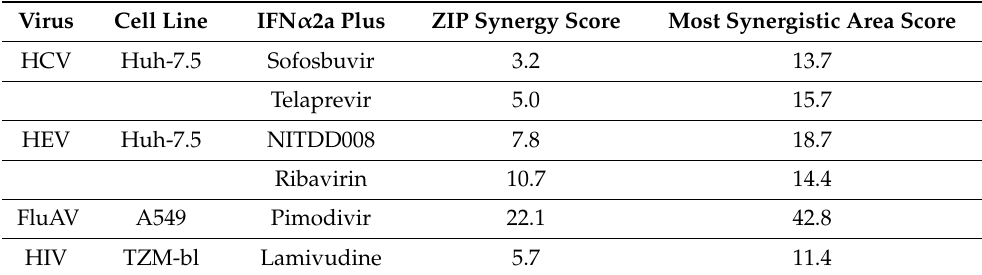
Table 1. Synergy and the most synergistic area scores of IFN α 2a-based combinations tested against HCV, HEV, FluAV, and HIV infections in cell cultures.